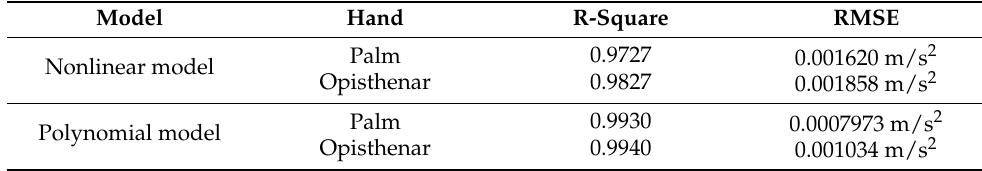
Table 5. R-square and RMSE of two